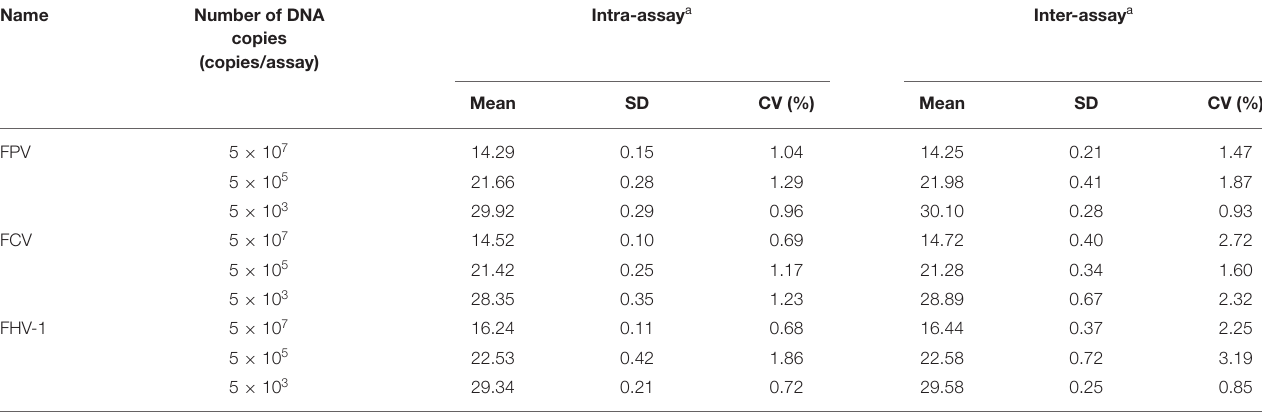
TABLE 3 | Intra- and inter-assay reproducibility of the triplex assay.